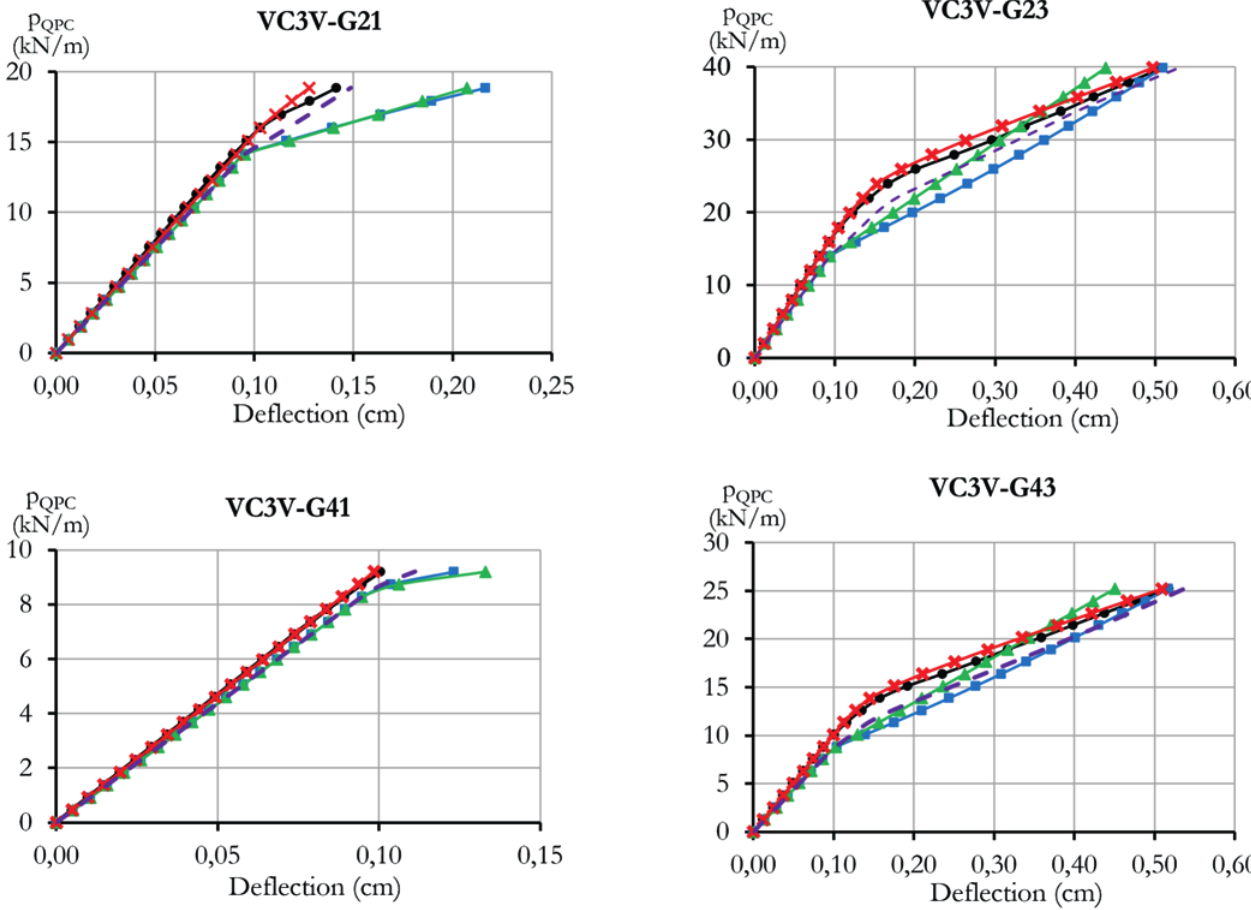
Applied load versus maximum deflection for beams VC3V-G21, VC3V-G23, VC3V-G41 and